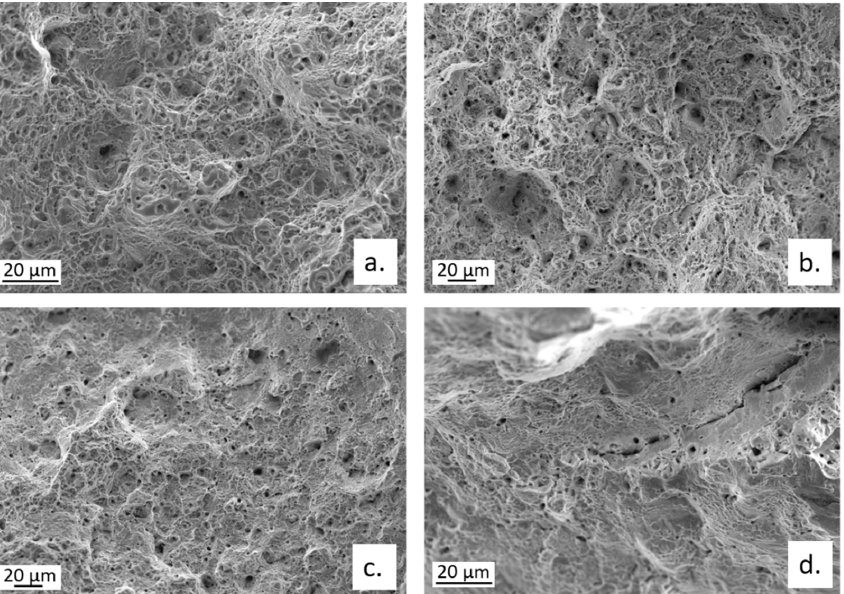
Figure 20. Fractographic analysis of CW724R tensile samples after SSRT carried out in ( a ) air or in SDW solutions containing ( b ) 100 ppm; ( c ) 400 ppm; and ( d ) 700 ppm chlorides.